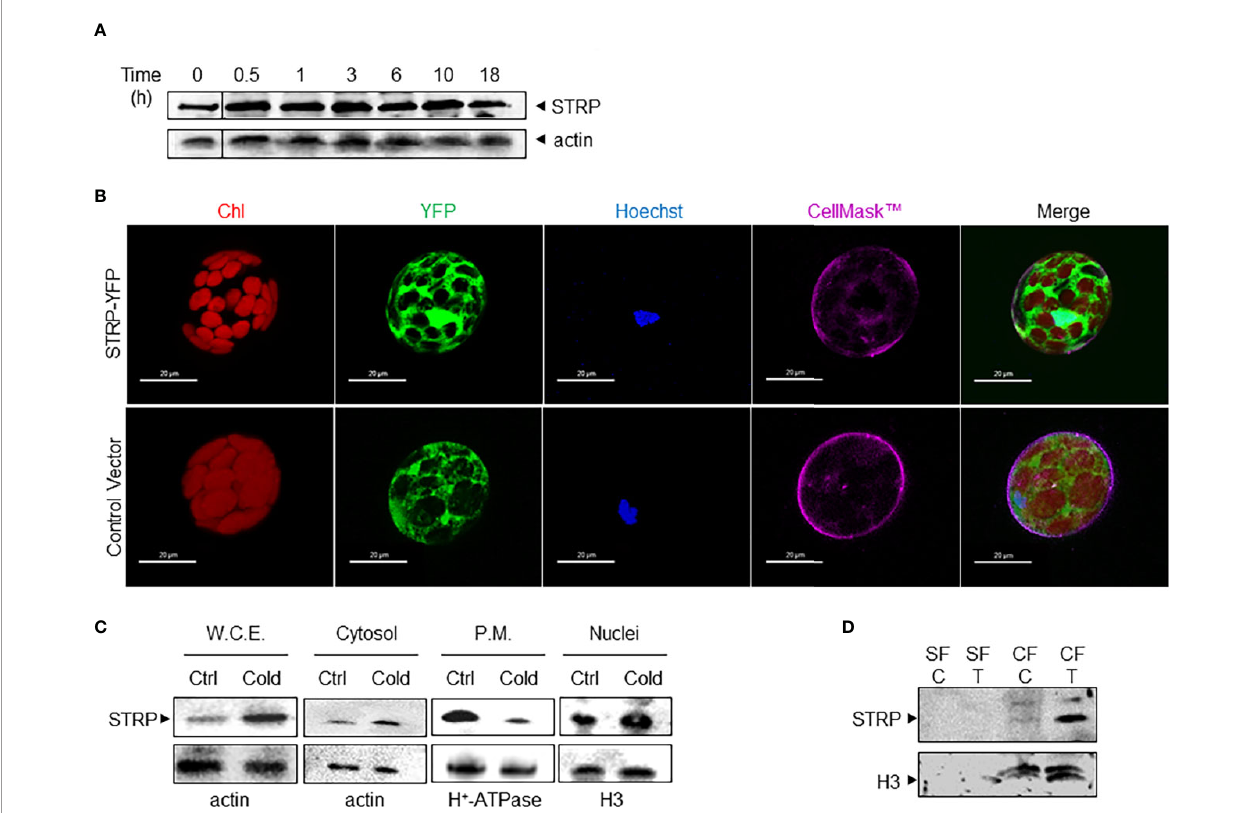
FIGURE 1 | Cold stress affects STRP subcellular localization and levels. (A) : time course of STRP levels under cold stress. A. thaliana whole cellular extract was prepared after 0.5, 1, 3, 6, 10, and 18 h of cold stress. 15 m g of samples were separated by SDS-PAGE and subjected to western blotting with anti-STRP antibodies. Actin was used as loading control. (B) : STRP subcellular localization in A. thaliana mesophyll protoplasts expressing STRP-YFP fusion protein. CellMask ™ Orange and Hoechst 33342 were used as marker for plasma membrane and nuclei, respectively. YFP signal is shown in green, chlorophyll in red, Hoechst 33342 in blue and CellMask ™ Orange is pseudo-coloured in magenta. Scale bar, 20 m m. (C) : 15 µg of proteins from whole cellular extract (W.C.E.), cytosol, plasma membrane (P.M.) and nuclei were separated by 12% SDS-PAGE and analysed by western blotting with anti-STRP antibodies. Actin, H + -ATPase and H3 were used as loading control. (D) : analysis of STRP levels in the soluble nuclear fraction (SF) and in the chromatin fraction (CF) obtained from control (C) and cold treated (T) nuclei. 20 µg of SF and CF were separated by SDS-PAGE, blotted onto PVDF membrane and immunodecorated with anti-STRP antibodies. Histone H3 was used as marker for